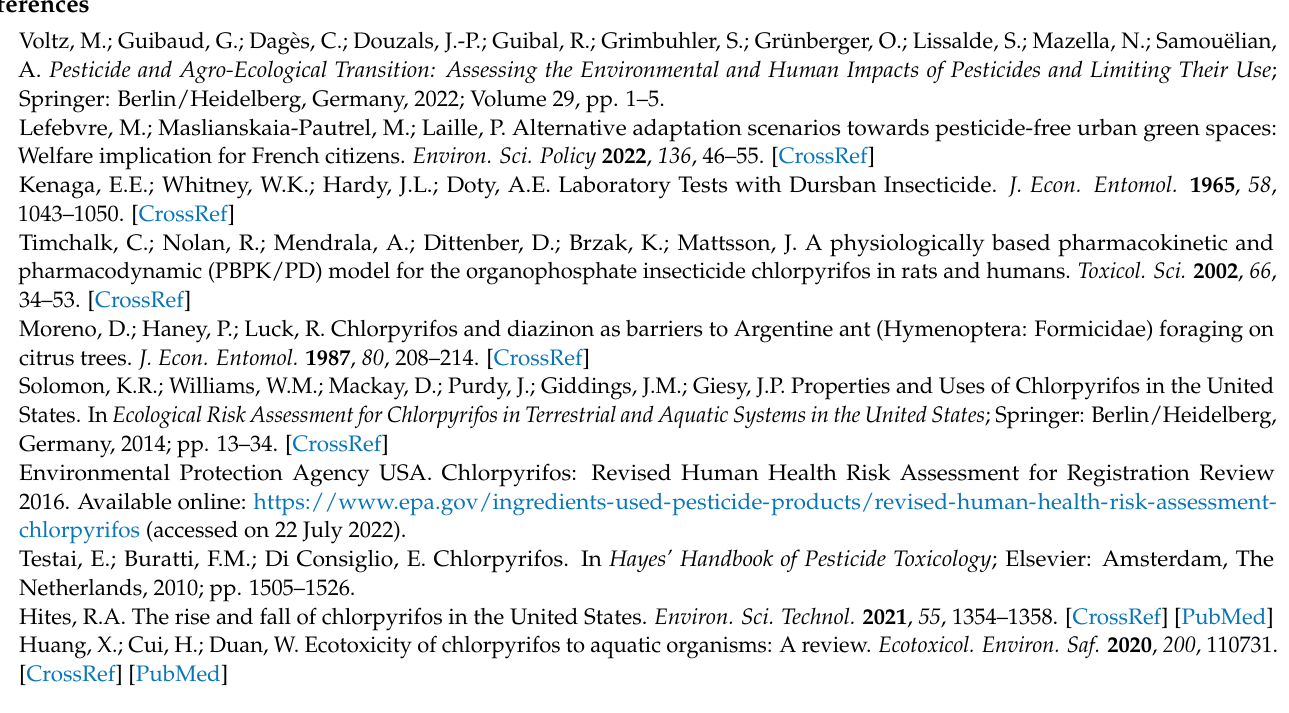
(lower) on the membrane combined with serial CHLP-mAb dilutions. Figure S2: Overview of LFIA results for all the assessed environmental water samples. Each concentration was tested in duplicate. Figure S3. LFIA detection of chlorpyrifos (applied and dried) on apple blossom after water extractions by visual (A,B) readout and using a cube digital imager (C), for duplicate readings (D). The test line signals are divided by the control line signals to acquire T/C ratios. Figure S4: Simplification of the LFIA by drying assay reagents and buffer in tubes (A), after which a water sample containing chlorpyrifos is added and the LFIA inserted (B), showing 10 µ g/L sensitivities for spot-based LFIAs in duplicate measurements after visual readout